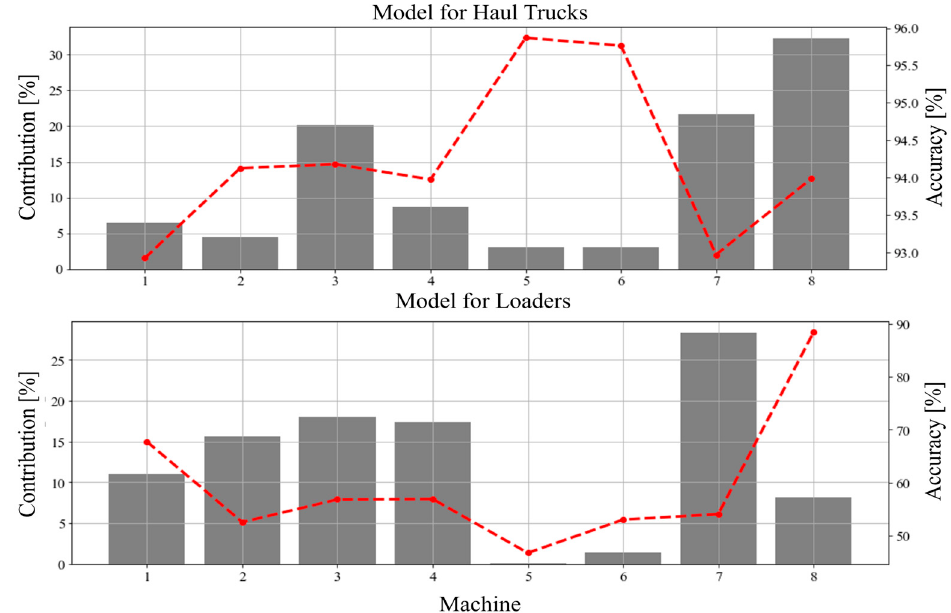
Figure 11. Accuracy (red line) for data from machines in relation to their contribution (gray bars) to the overall sample size (Upper—Haul Trucks, Lower—Loaders).